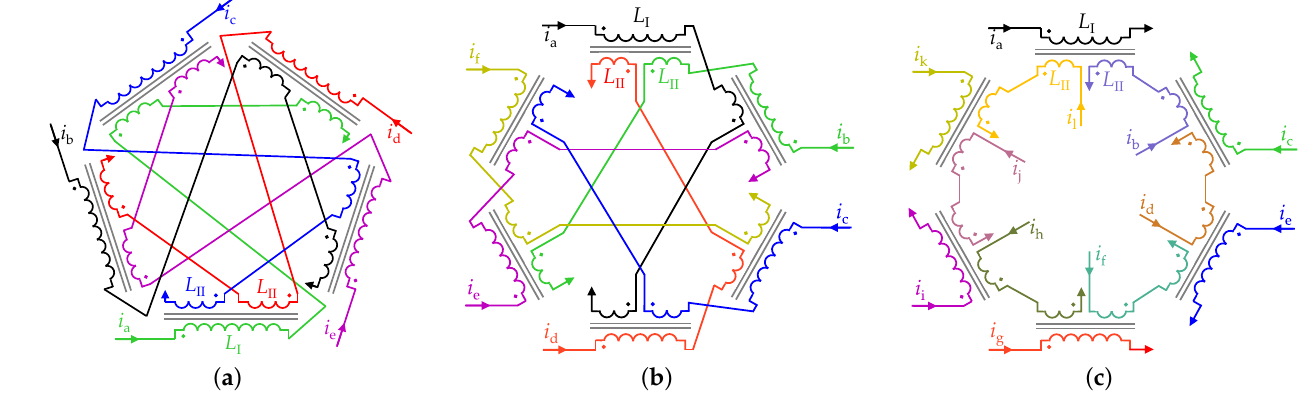
Figure 27. Examples of passive x - y filters, based on [140]. ( a ) For n = 5 symmetrical WSA [142]. ( b ) For n = 6 asymmetrical WSA [143]. ( c ) For n = 12 symmetrical WSA